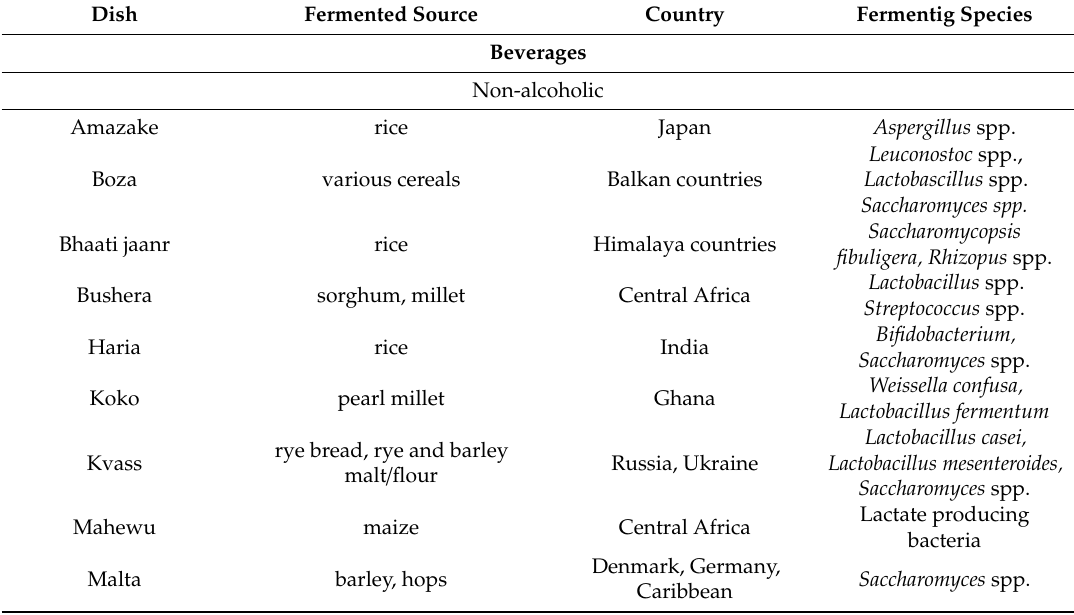
Table 1. Products from fermented